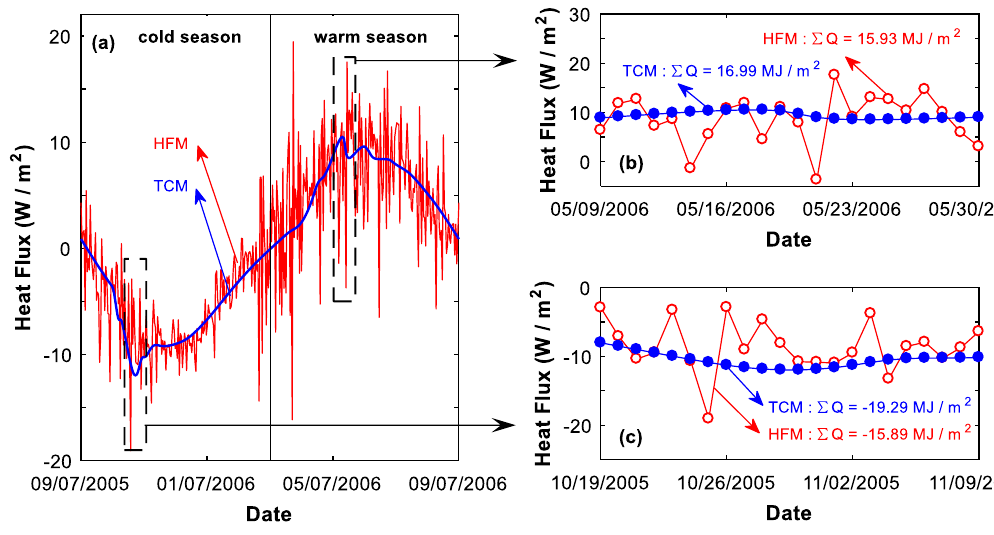
Figure 5. During the freezing/thawing period, the TCM imposes more energy to the natural ground surface than the HFM does. ( a ) The entire year, ( b ) the thawing period, and ( c ) the freezing period.